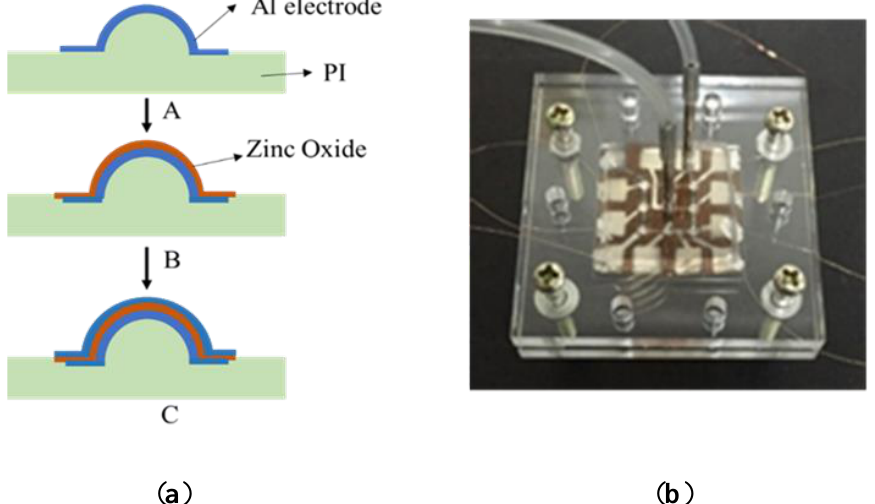
Figure 6. ( a ) Flow chart of preparation of the self-focusing ultrasonic transducer array on a PI substrate; ( b ) a picture of the microfluidic transfection biochip.